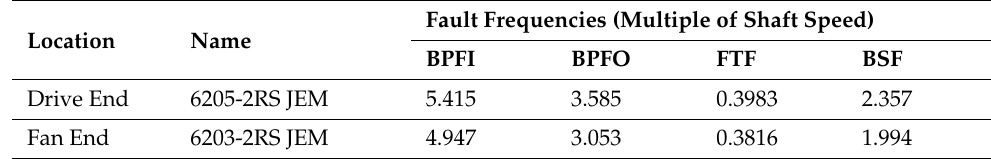
Table 1. Bearing fault frequencies details (BPFI/O: inner/outer race, FTF: cage, BSF: ball).